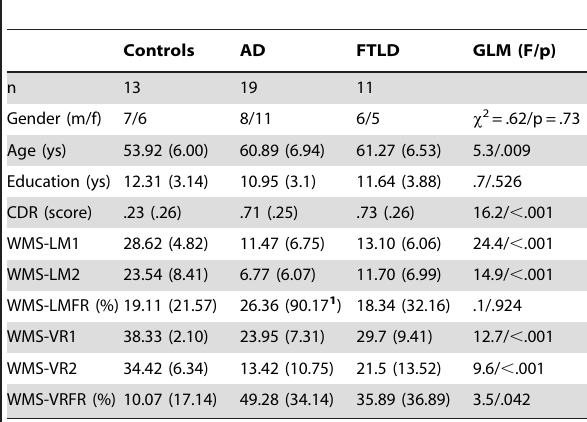
Table 1. Subject characteristics and test results for each